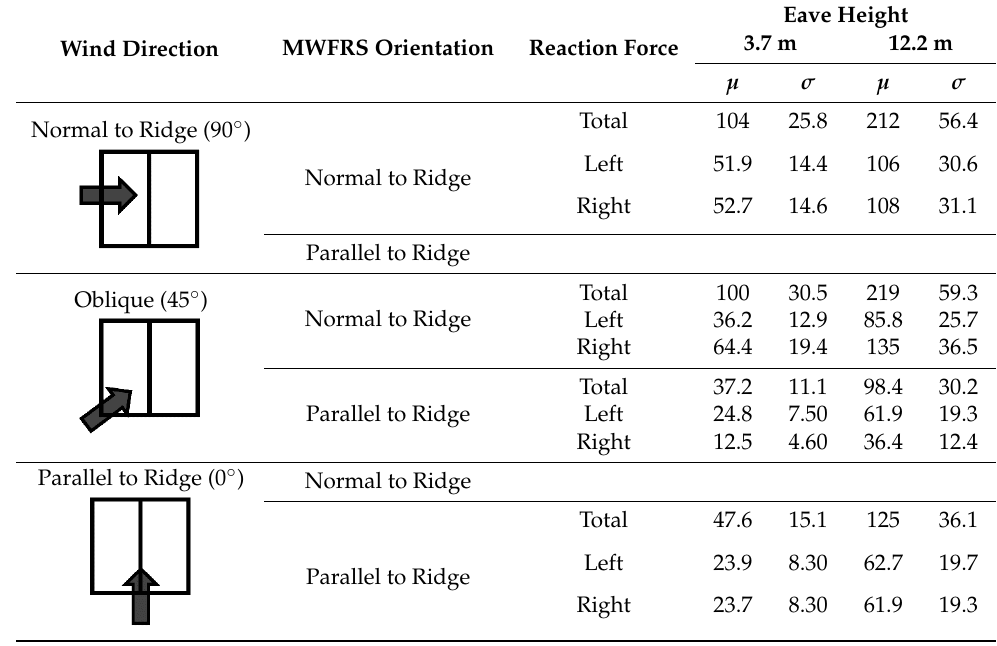
Table 3. Base shear (kN) from wind tunnel test data. MWFRS Orienta- Wind Direction Normal to Ridge (90°) Normal to Ridge Parallel to Ridge Oblique